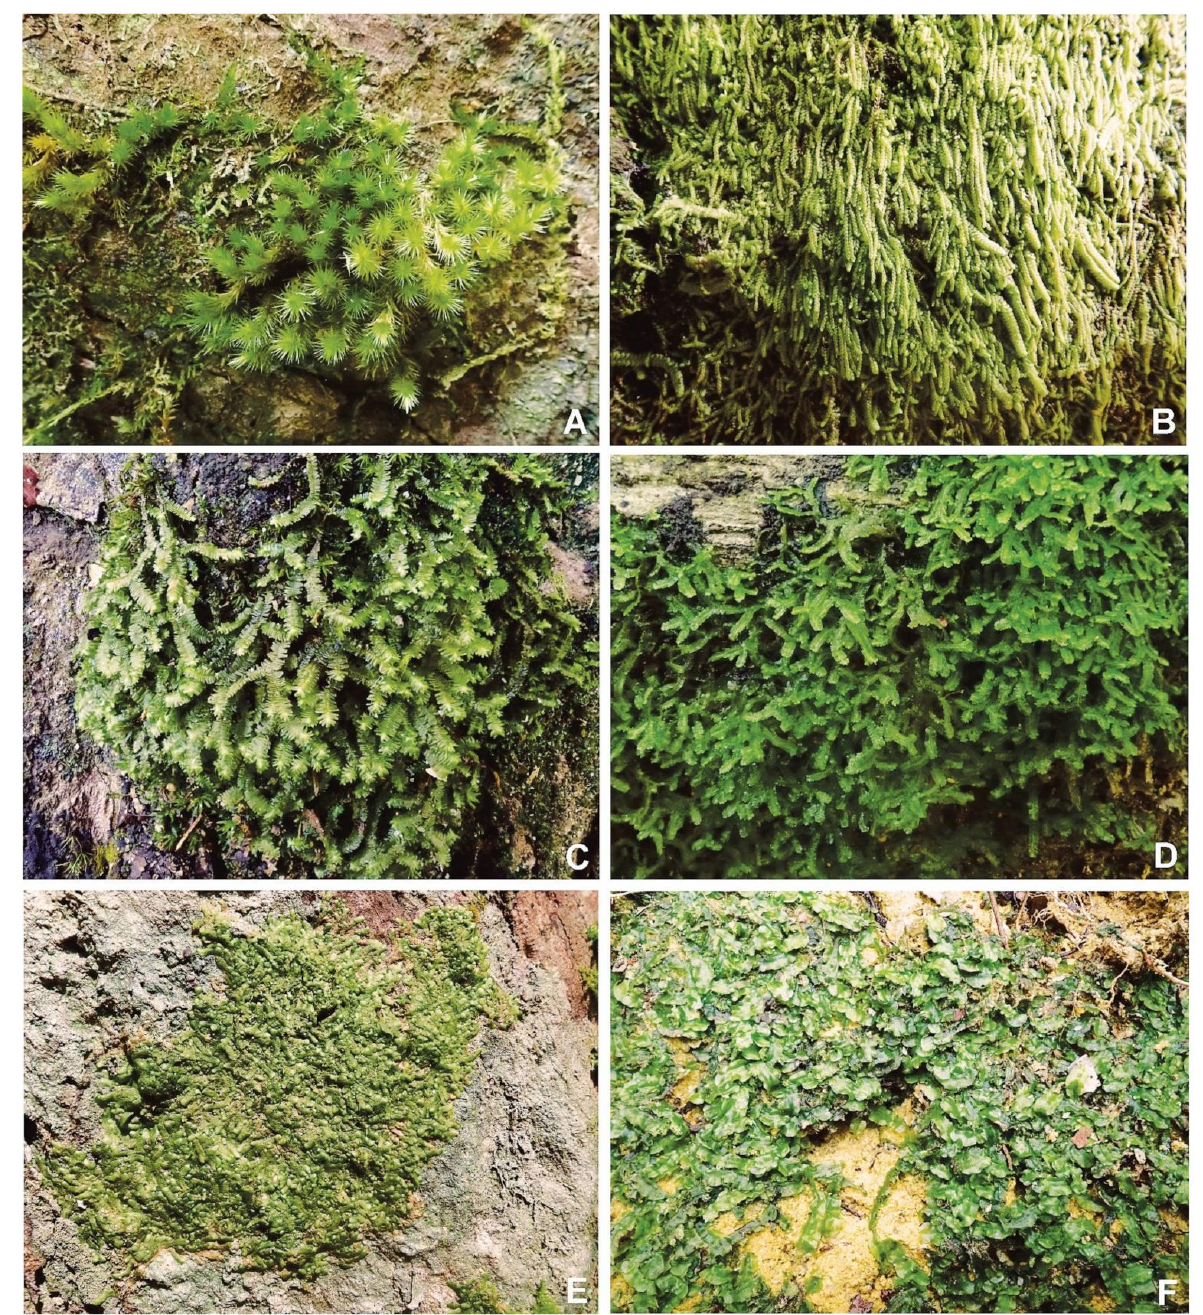
Figure 2. Bryophyte species and their habit from Lata Belatan. ( A ) Oedicladium pseudorufescens (Hampe) B.C. Tan and Mohamed. ( B ) Drepanolejeunea ternatensis (Gottsche) Schiffn. ( C ) Bazzania asym- metrica (Steph.) N. Kitag. ( D ) Bazzania calcarata (Sande Lac.) Schiffn. ( E ) Pycnolejeunea grandiocellata Steph. ( F ) Pallavicinia lyellii (Hook.)